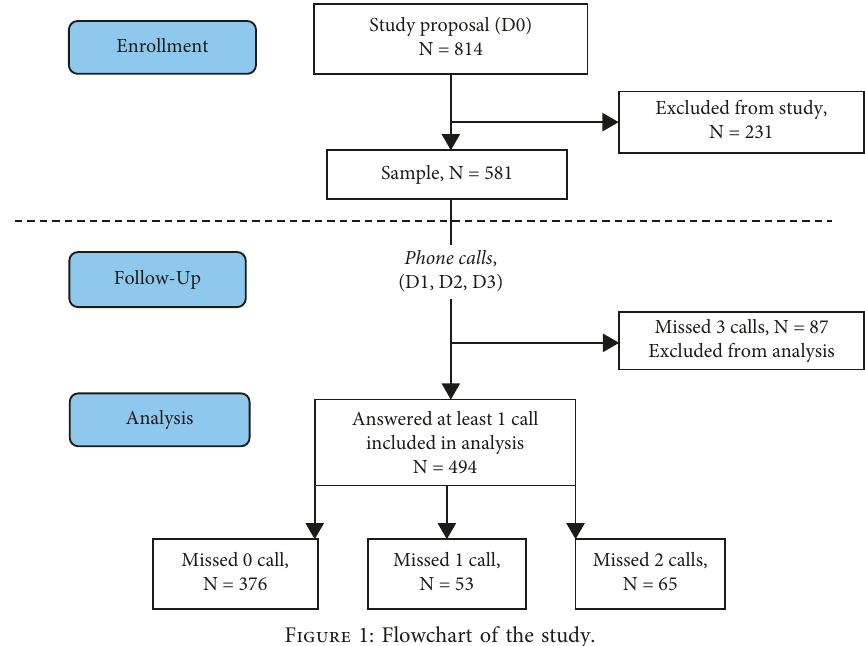
Figure 1: Flowchart of the